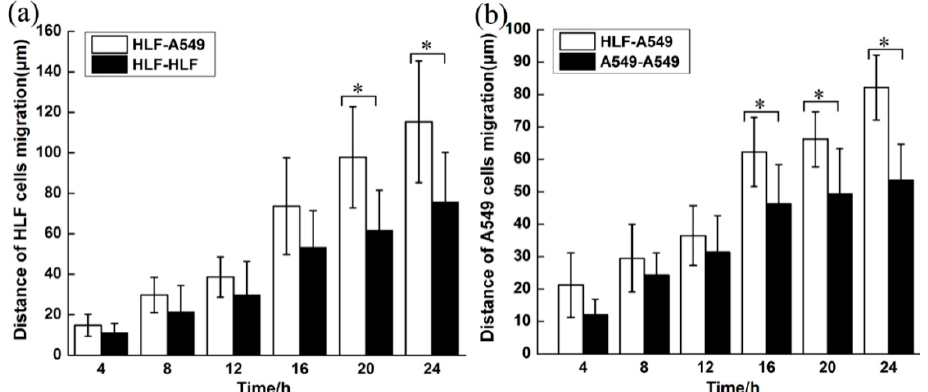
Figure 6. Histograms of average migration distances of cells for co-culture group compared with control groups. ( a ) Average migration distance of HLF at corresponding different times for HLF–A549 and HLF–HLF groups. ( b ) Average migration distance of A549 at corresponding different times for HLF–A549 and A549–A549 groups. (* p <